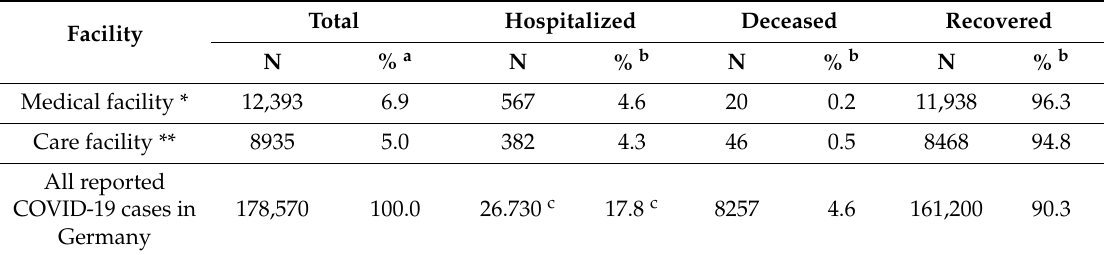
Table 1. Cases of SARS-CoV-2 infections of employees from medical and care